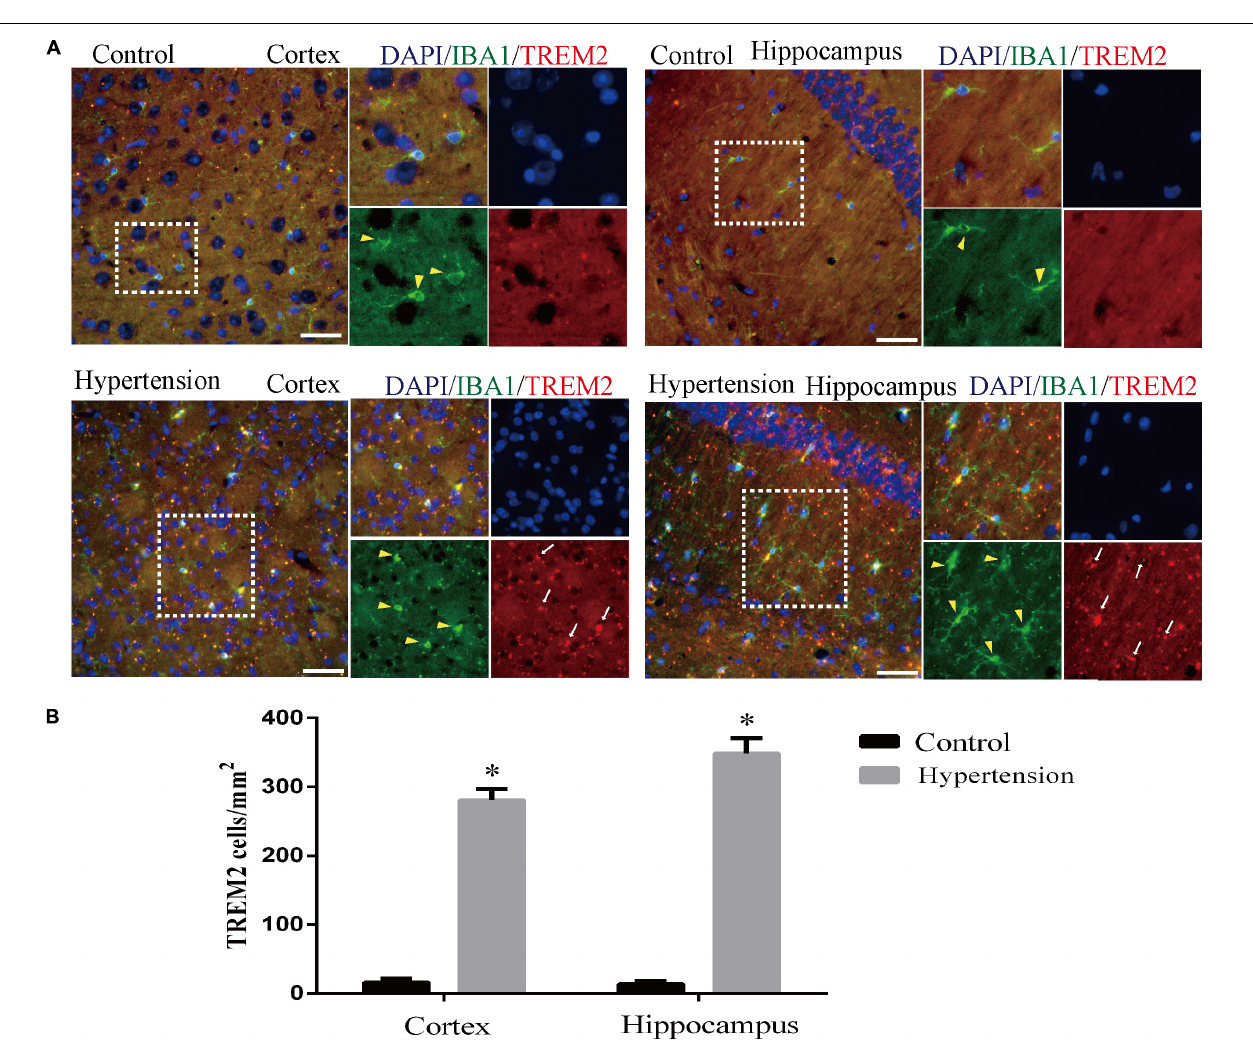
FIGURE 7 | Angiotensin II-induced hypertension increased the expression of triggering receptor expressed on myeloid cells 2 (TREM2) co-localization with microglia marker IBA1 in middle-aged mice. (A) Representative images of brain slices stained with the anti-IBA1 (green) and anti-TREM2 antibodies (red) in the cortex and hippocampus of the mice in the control and hypertension groups. (B) Histograms comparing the number of TREM2-positive cells in the cortex and hippocampus of mice in the control and hypertension groups (immunofluorescence, × 40, scale bar = 50 µ m). Data are expressed as the means ± SD. * p <